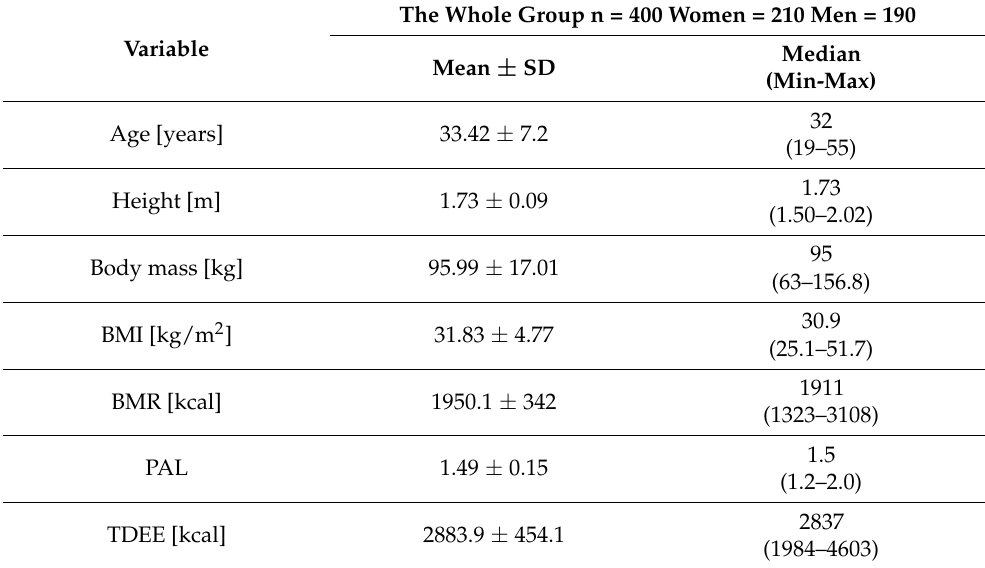
Table 2. General characteristics of participants at the beginning of the intervention.